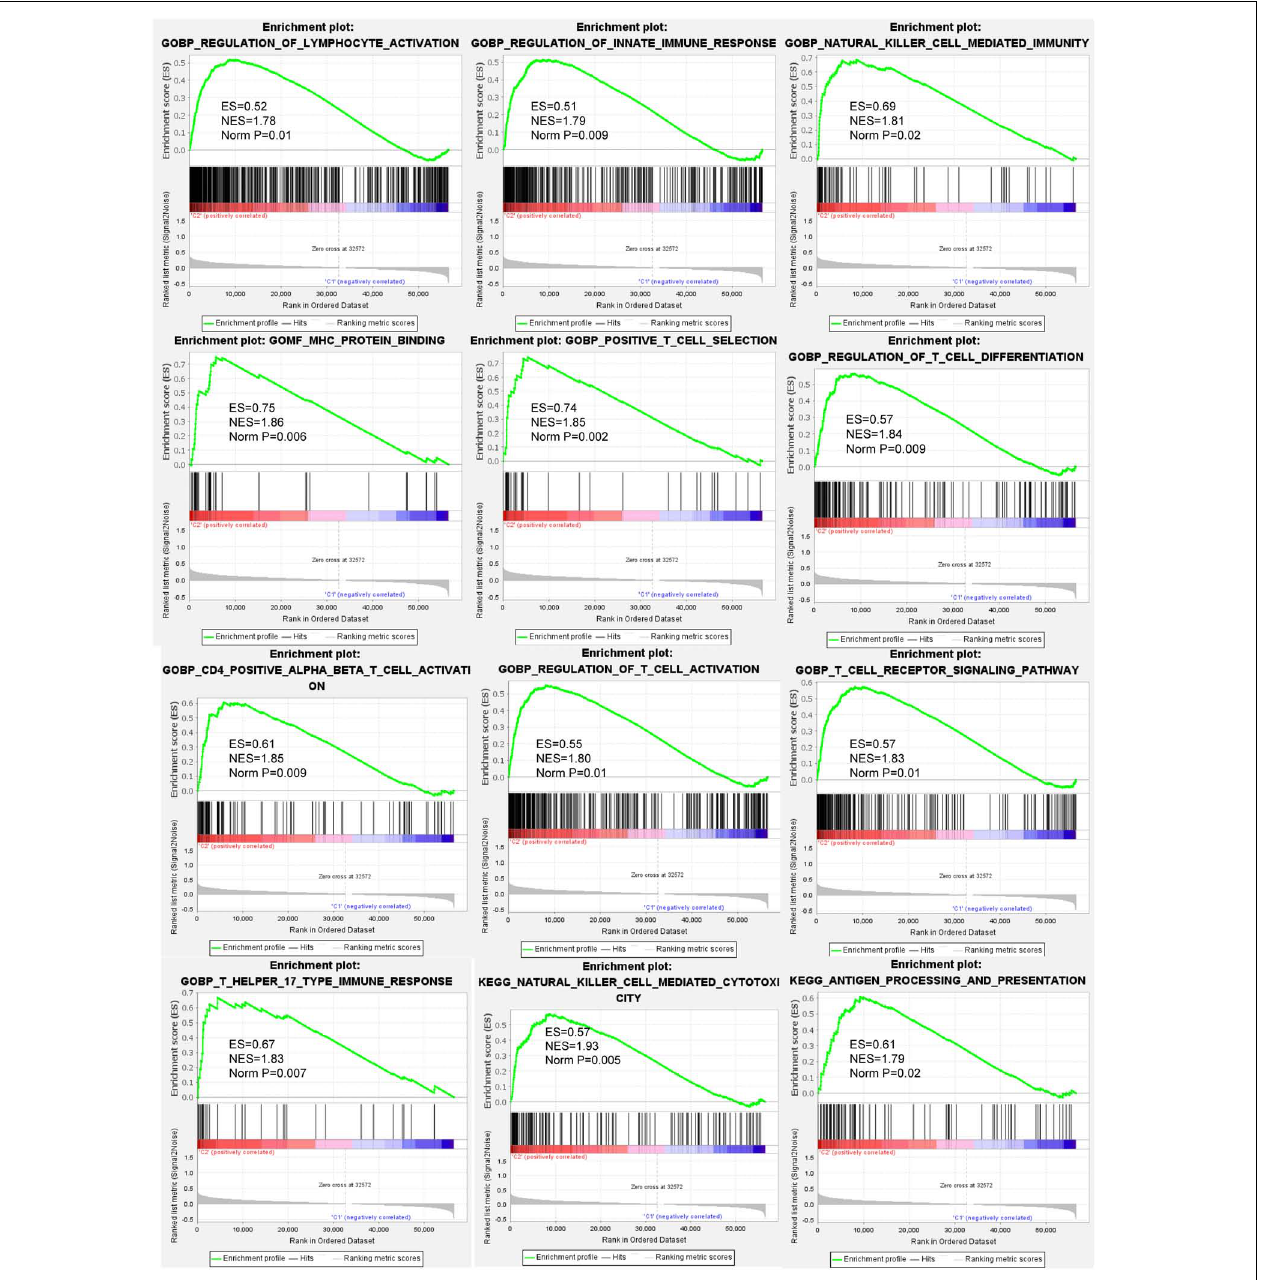
FIGURE 4 | Gene set enrichment analysis (GSEA) indicating that various immune response processes were enriched in the BC cluster 3 patients compared to other BC subtypes. The above results demonstrated that biological processes such as lymphocyte activation, innate immune response, natural killer cell-mediated immunity, MHC protein binding, T cell activation, antigen processing and presentation, and so on were positively enrichment in BC cluster 3.